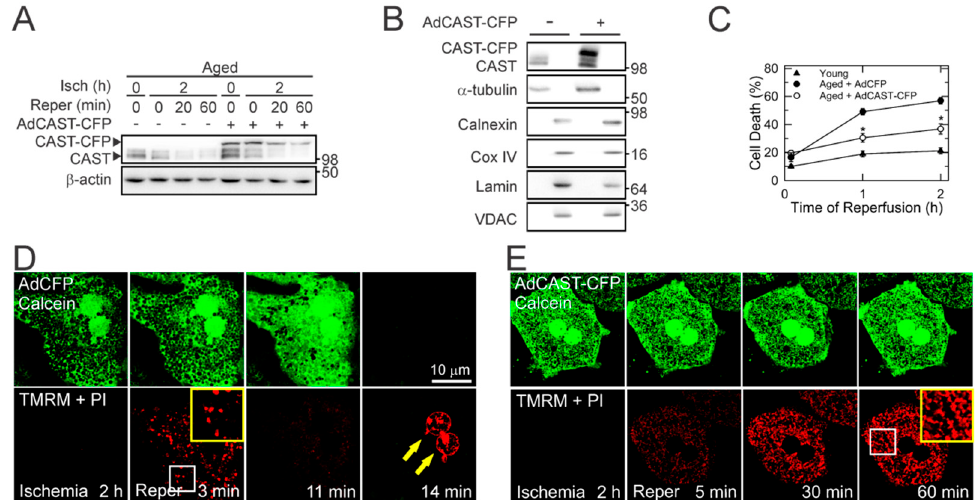
Figure 3. Cytoprotection by CAST overexpression. ( A ) IB analysis of CAST in aged hepatocytes during I/R with and without CAST overexpression. Representative IB from six independent cell isolations. ( B ) Subcellular fractionation of CAST with and without CAST overexpression. Calnexin, α -tubulin, cytochrome c oxidase (COX) IV and voltage-dependent anion channel (VDAC), and Lamin were used as a surrogate marker of endoplasmic reticulum, cytosol, mitochondria, and nucleus, respectively. ( C ) Cell death after I/R of young and aged hepatocytes in the presence of CAST overexpression ( n = 9). Representative confocal images of calcein, TMRM, and PI in reperfused aged hepatocytes with ( E ) and without ( D ) CAST overexpression. Arrows indicate nuclear labeling of PI (necrotic cell death). The yellow squares are enlarged images of insets. * p <